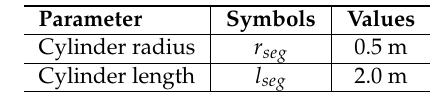
Table 6. Control parameters of feature extraction with 3D shape